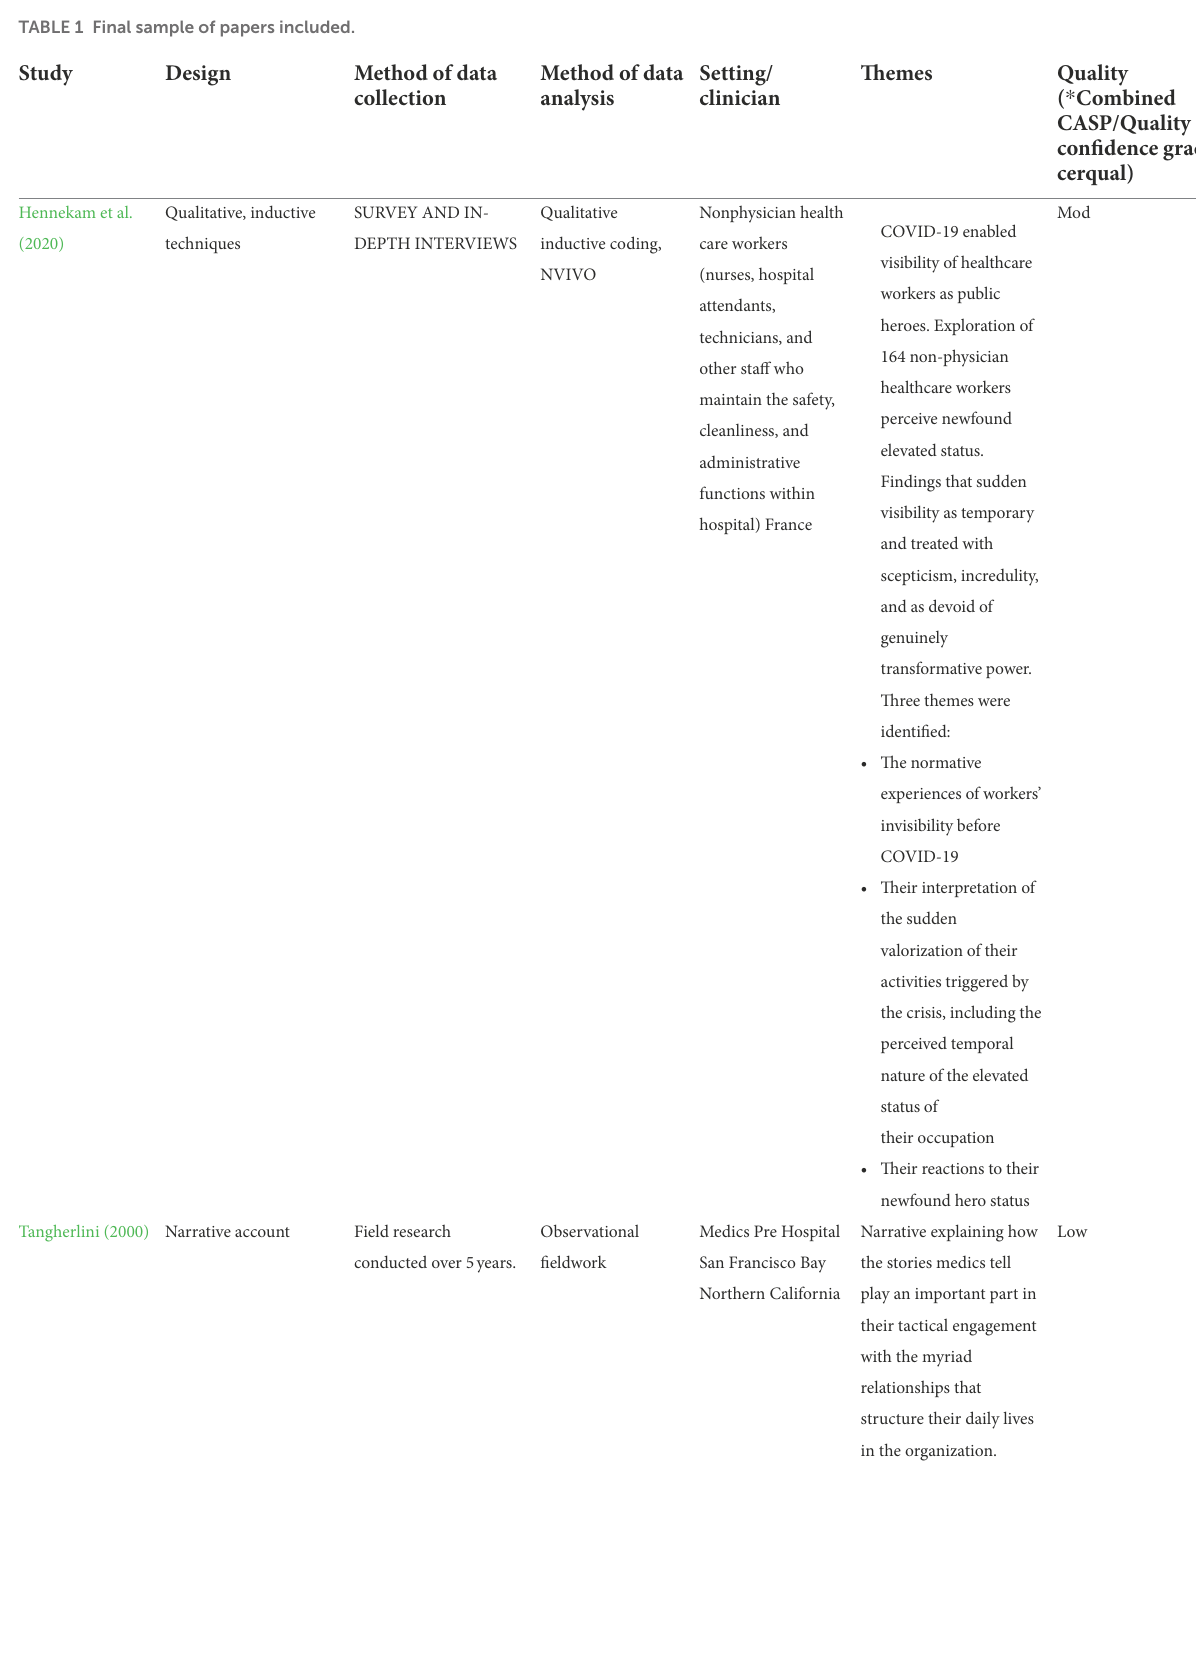
TABLE 1 Final sample of papers